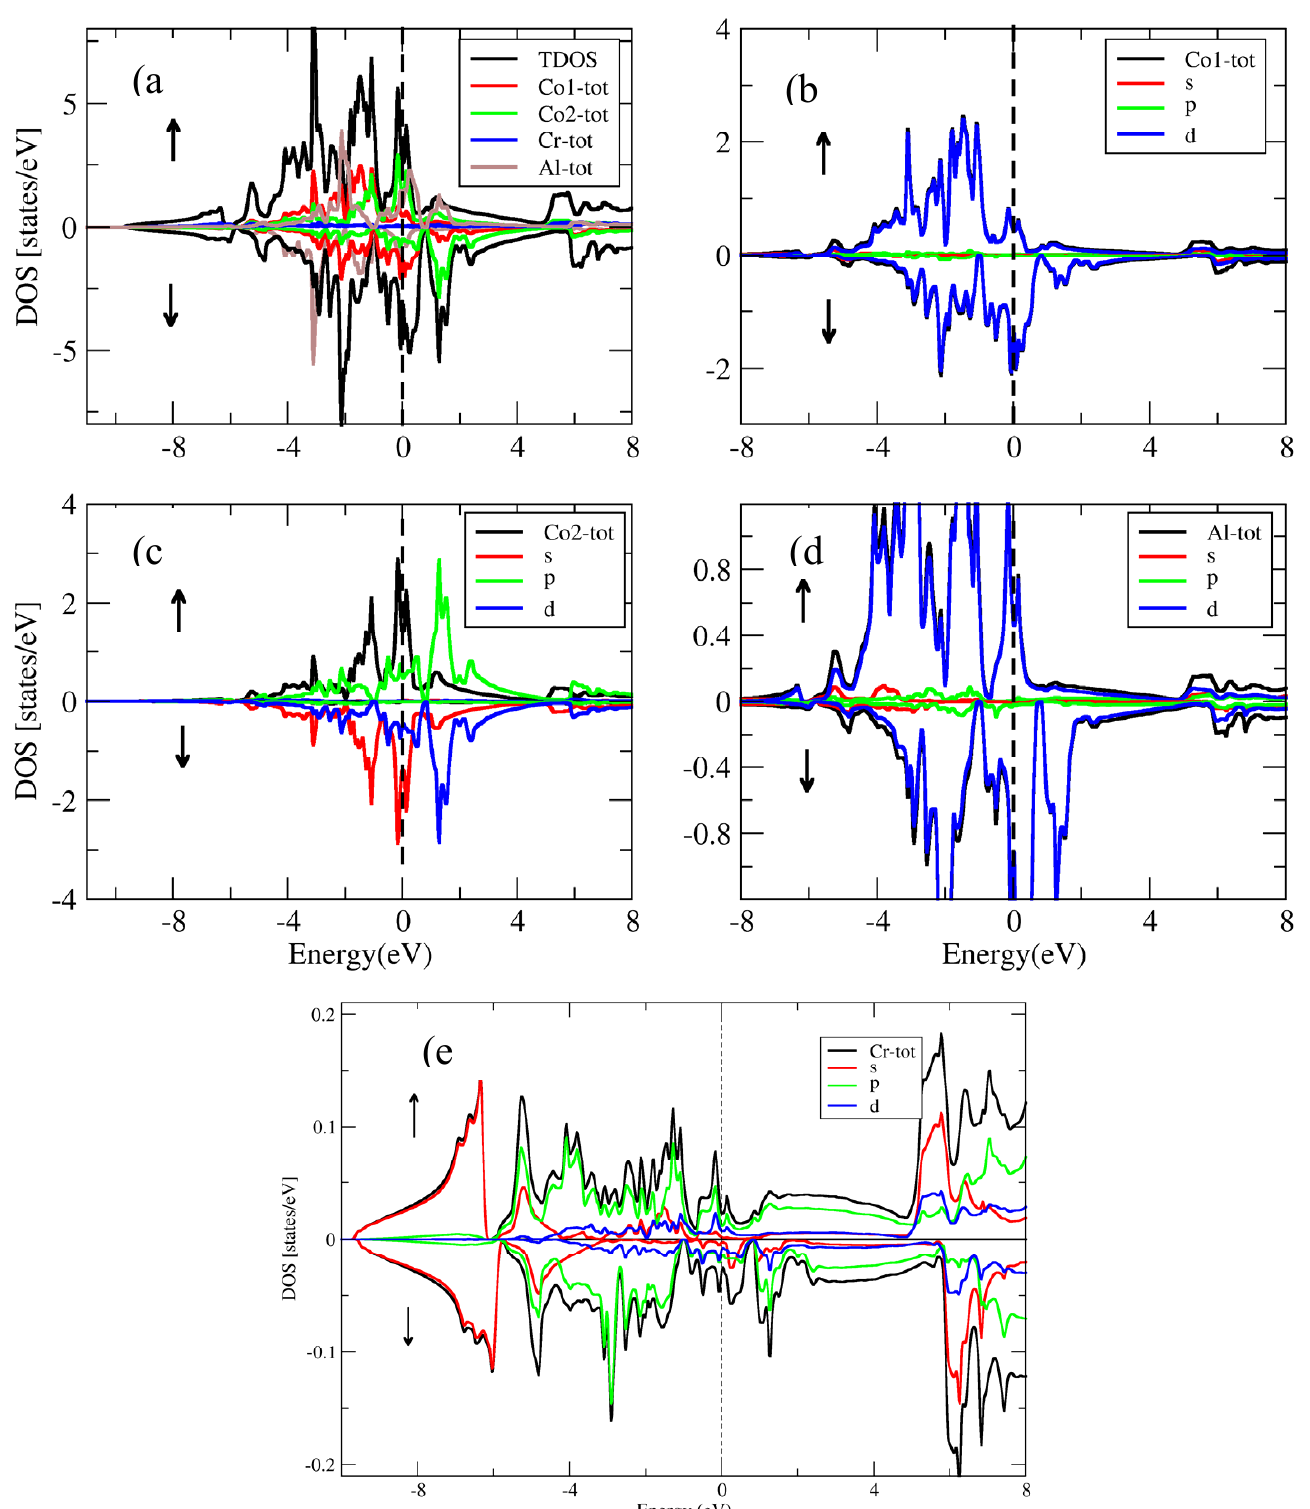
Figure 14. ( a ) Total density of states for the inverse Co 2 CrAl compound and partial density of states for ( b ) Co1 atom, ( c ) Co2 atom, ( d ) Al atom and ( e ) Cr atom.